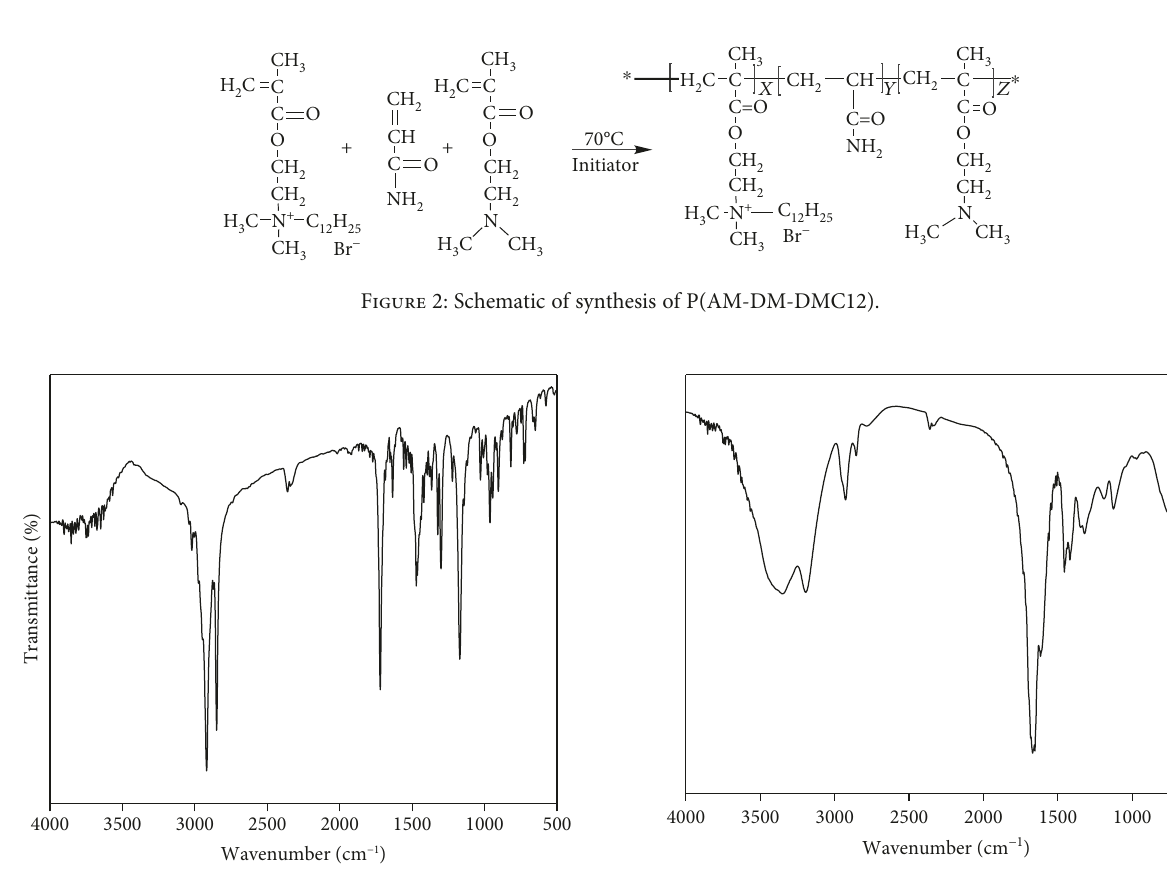
Figure 3: FT-IR spectrum of DMC12. Figure 4: FT-IR spectrum of